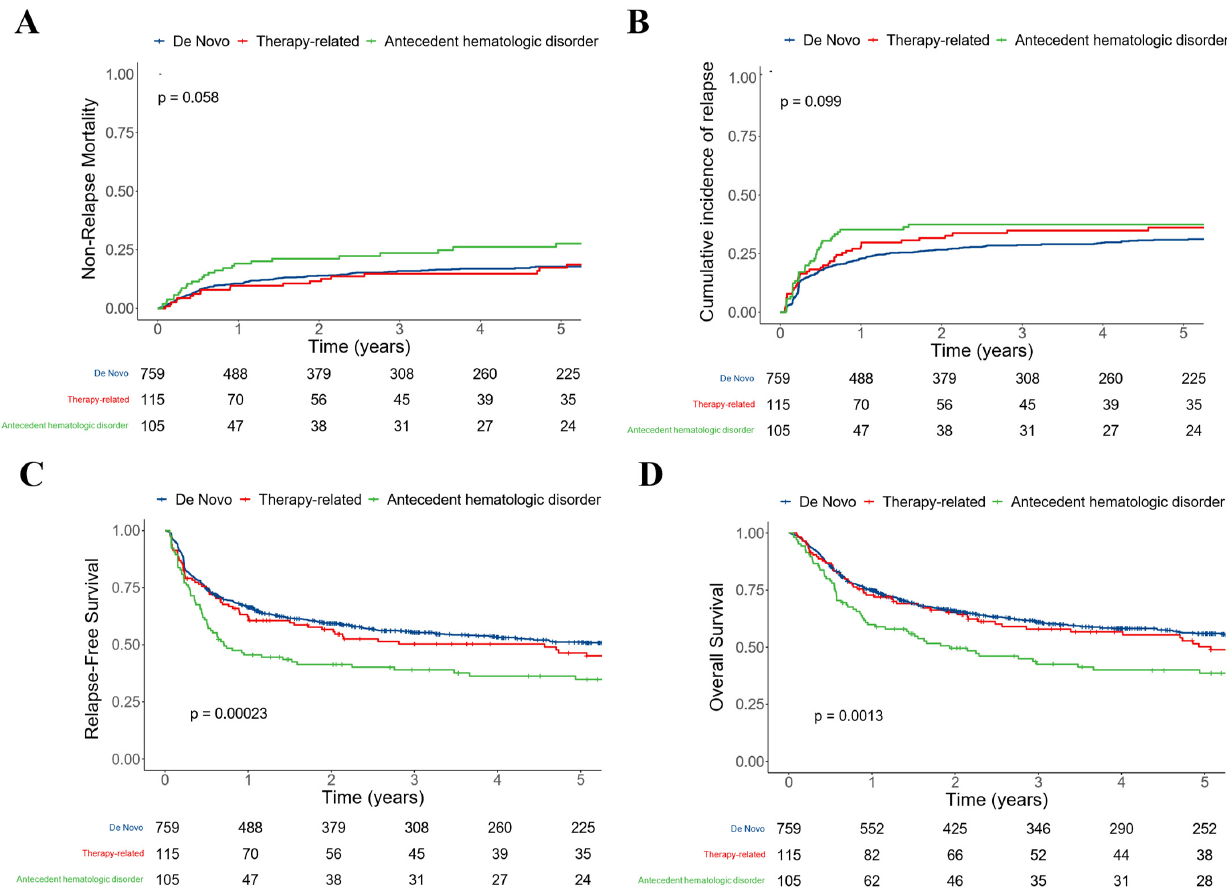
Figure 1. Post-HCT outcomes for 979 adults with AML undergoing allogeneic HCT while in first or second morphologic remission, stratified by disease status at diagnosis (de novo vs. therapy-related vs. antecedent hematologic disorder); ( A ) Non-relapse mortality; ( B ) relapse; ( C ) relapse-free survival; and ( D ) overall survival. Table 2. Univariable regression models of study cohort.